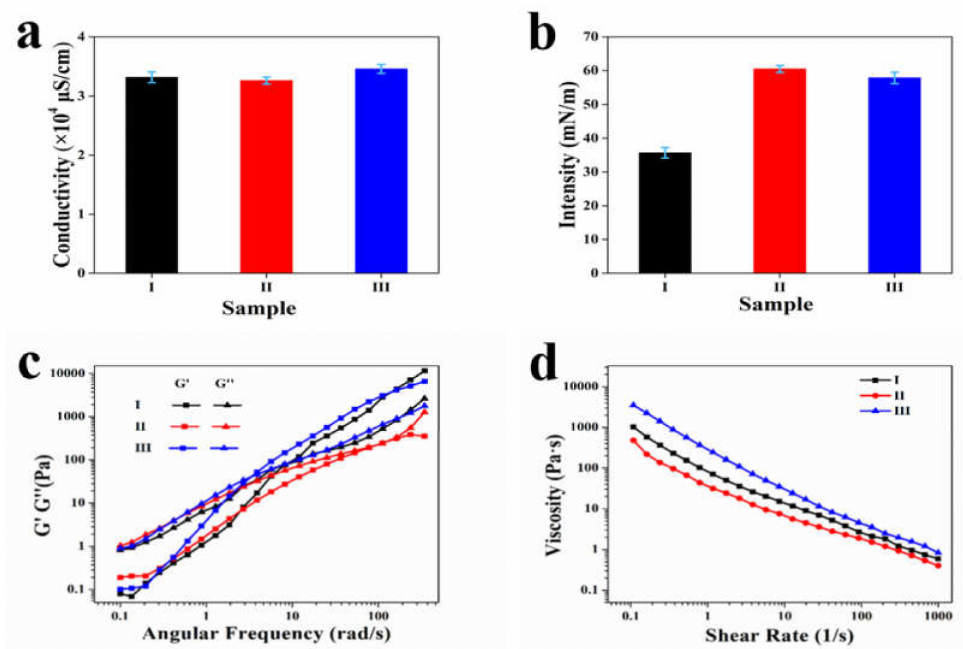
Figure 2. Properties of the four solutions: ( a ) conductivity; ( b ) surface tension; ( c ) storage (G (cid:48) ) and loss (G (cid:48)(cid:48) ) moduli as functions of frequency and ( d ) viscosity changes with shear